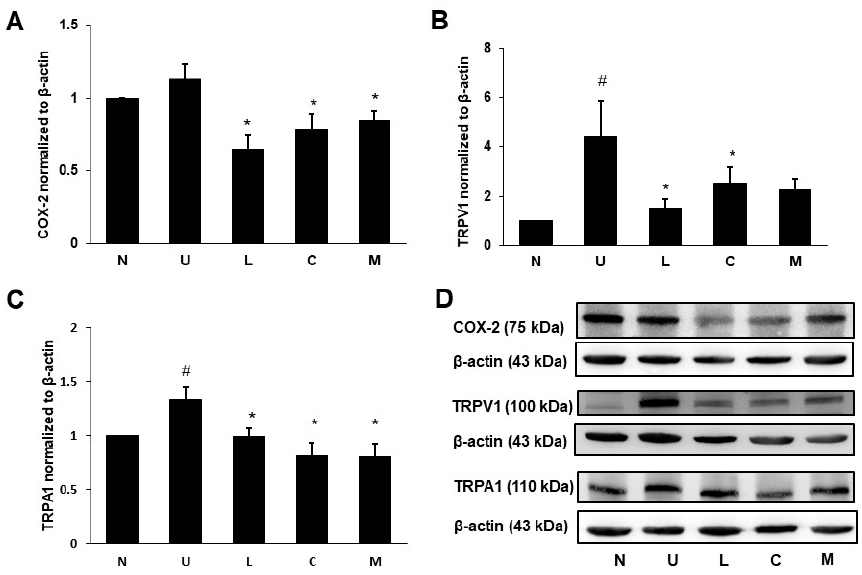
Figure 6. Effects of Lycium barbarum polysaccharides (LBP) and capsaicin (CAP) on colonic ( A ) Cy- clooxygenase-2 (COX-2), ( B ) Transient receptor potential cation channel V1 (TRPV1), and ( C ) Tran- sient receptor potential ankyrin 1 (TRPA1) protein expression. ( D ) Representatives of Western blot